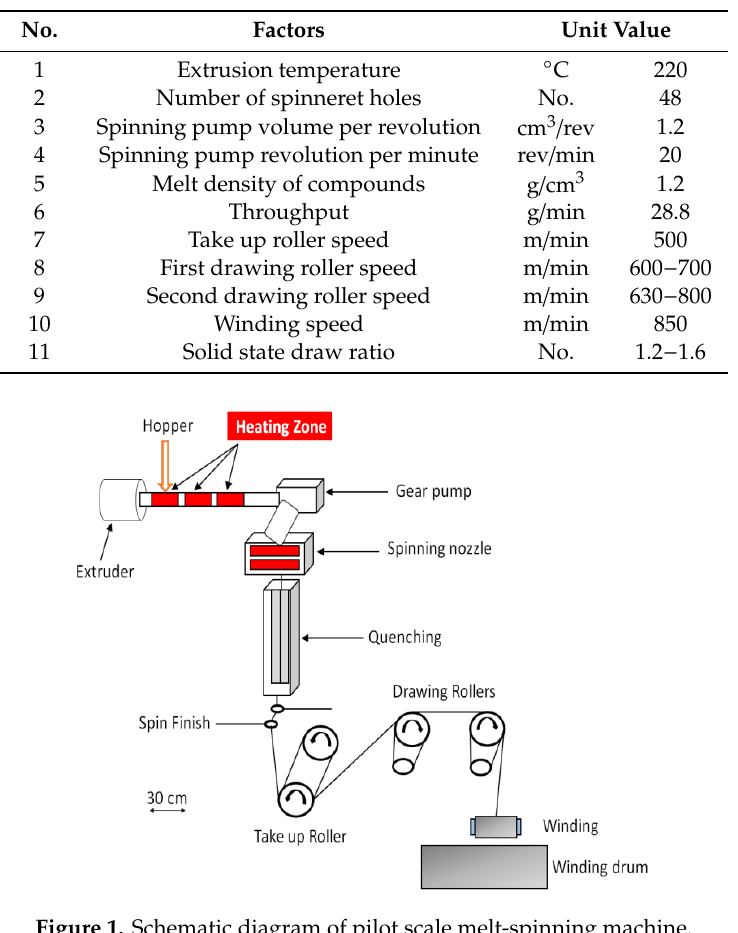
Figure 1. Schematic diagram of pilot scale melt ‐ spinning machine.